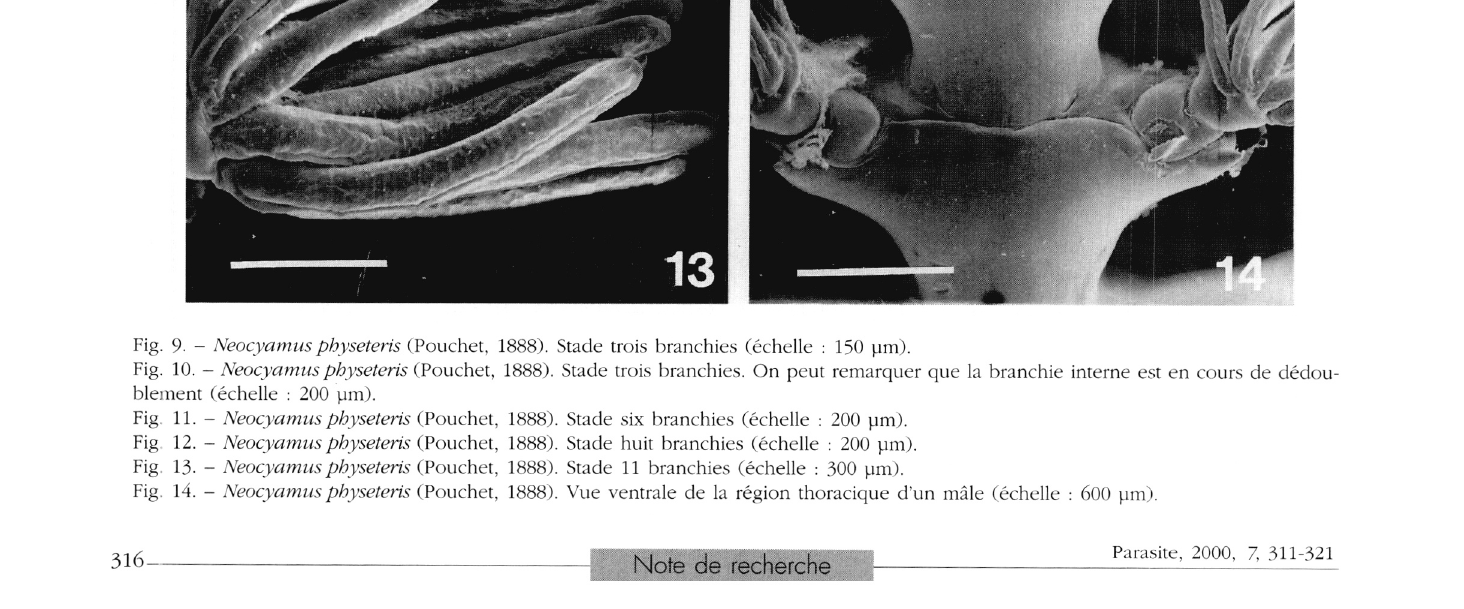
316 Note de recherche Parasite, 2000, 7,